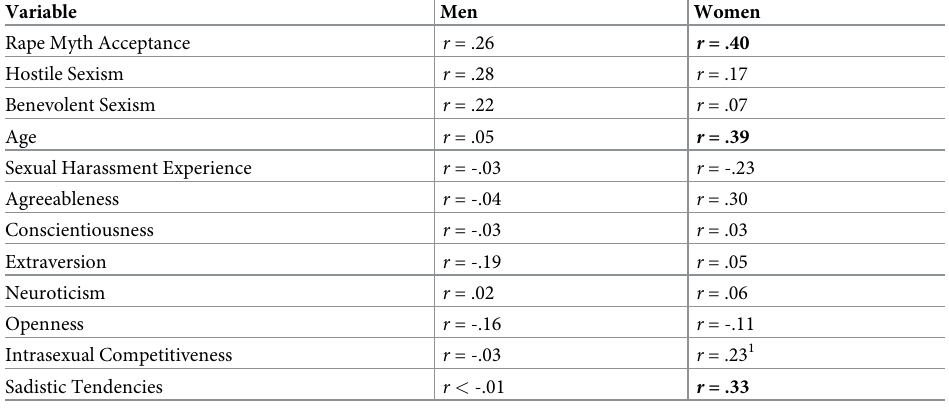
Correlations in bold are significant to the p < .05 level following Bonferroni correction. 1 this correlation becomes nonsignificant when gender identity is used rather than assigned biological